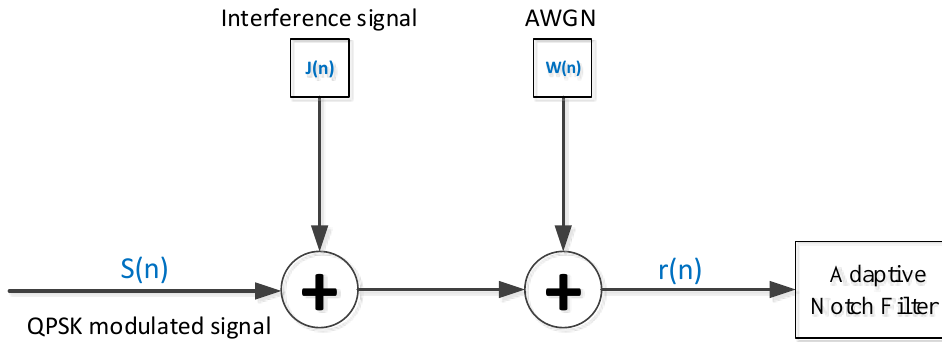
Figure 3. Block diagram of system model for a QPSK